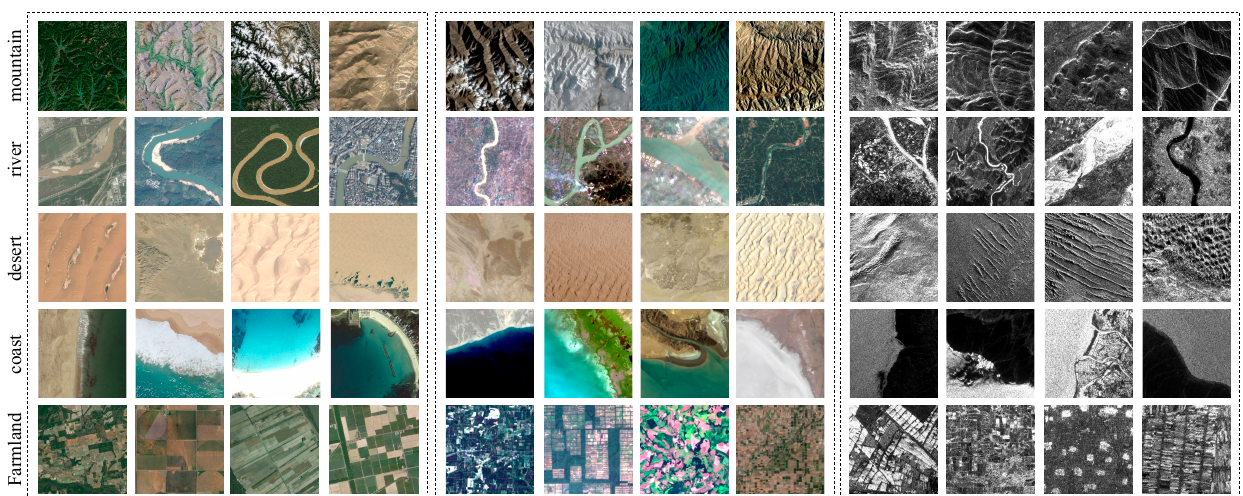
Figure 7. Example images of cross-domain data annotation.